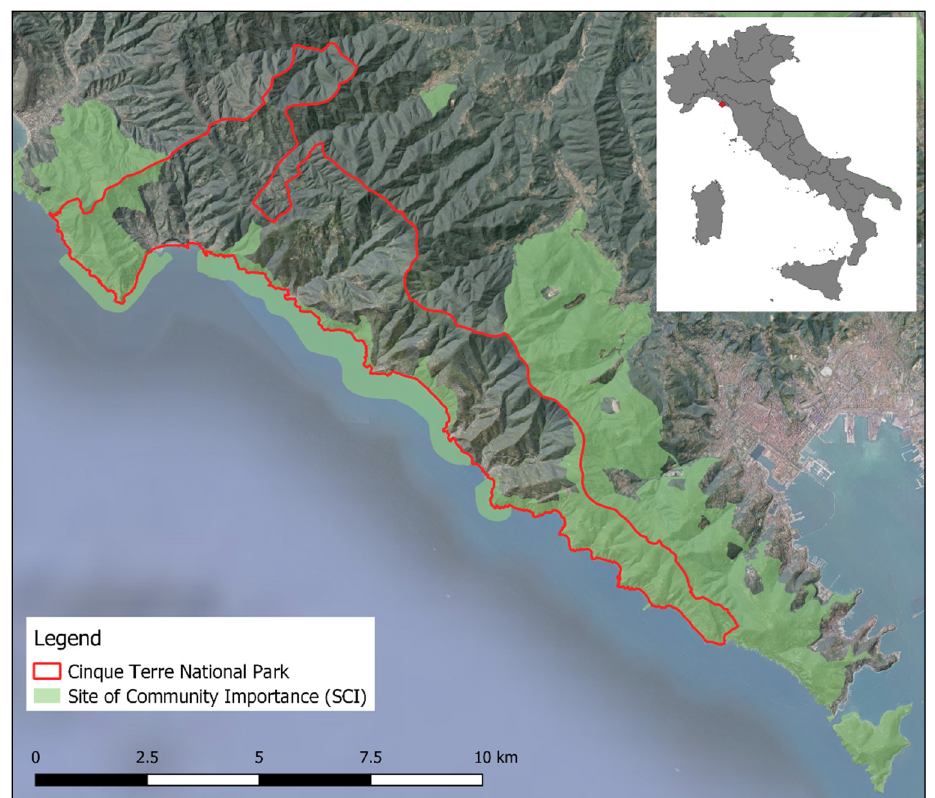
Figure 1. Cinque Terre National Park is located along the coast of Liguria Region, in Northern Italy.